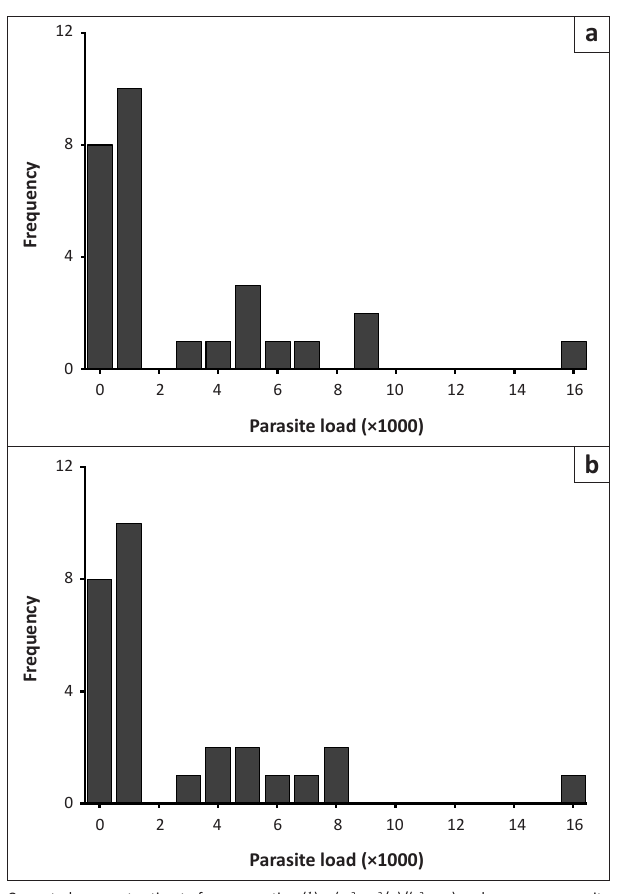
FIGURE 1: Observed frequency distributions of (a) all nematodes ( k = 0.35) and (b) Cooperia fuelleborni ( k = 0.34) in 28 African